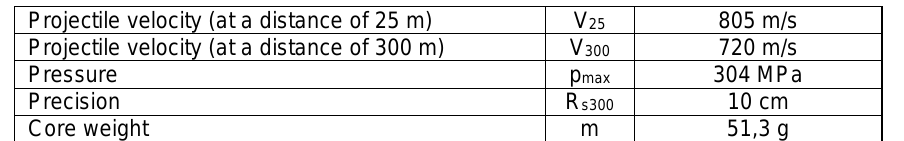
Table 1 – Ballistic characteristics of the bullet